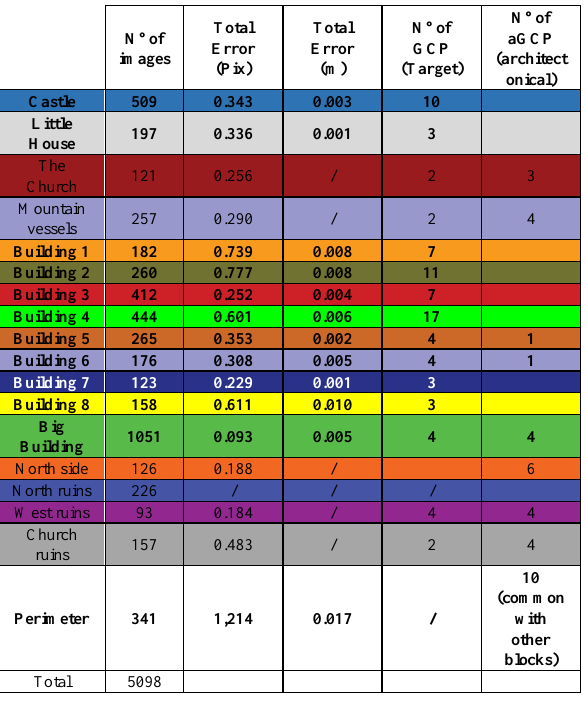
Table 1. Summary table of the diverse image block. In bold characters the blocks covered by total station survey used as reference for the whole area. On the right columns the number of target GCP and manually added architectonical ones